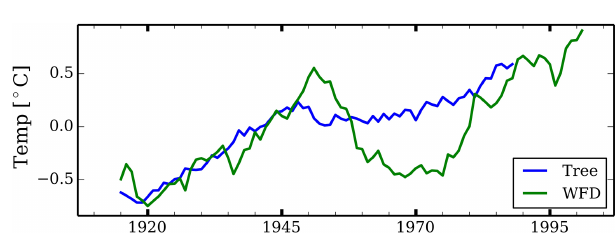
Figure 6. Trend comparison of the annual average air temperature data (15-year moving average) based on WCH-FD and tree-ring- based